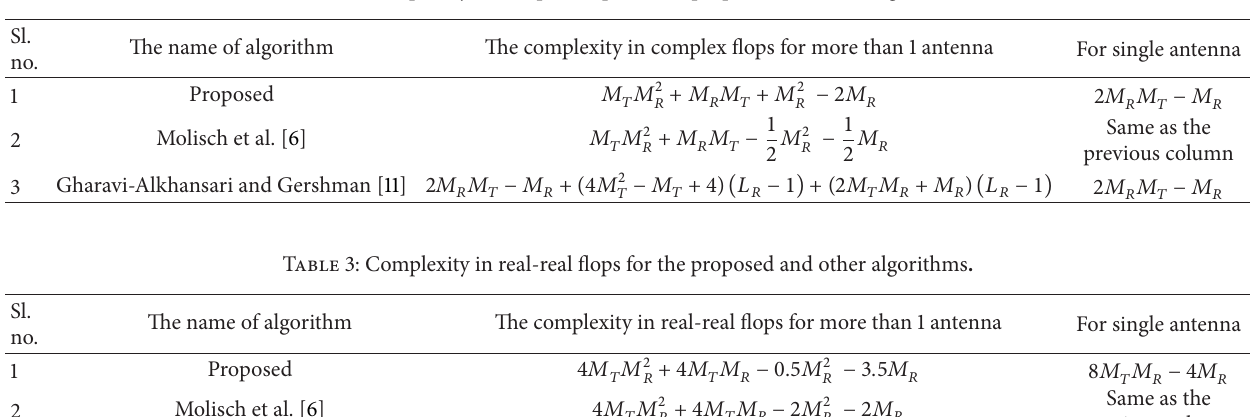
Table 2: Complexity in complex flops for the proposed and other algorithms.